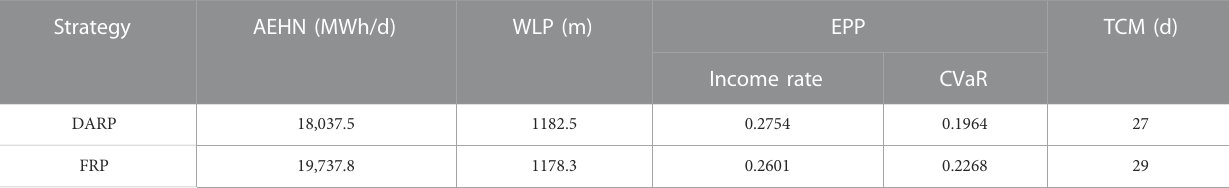
TABLE 6 Performance comparison of DARP and FRP. [40]